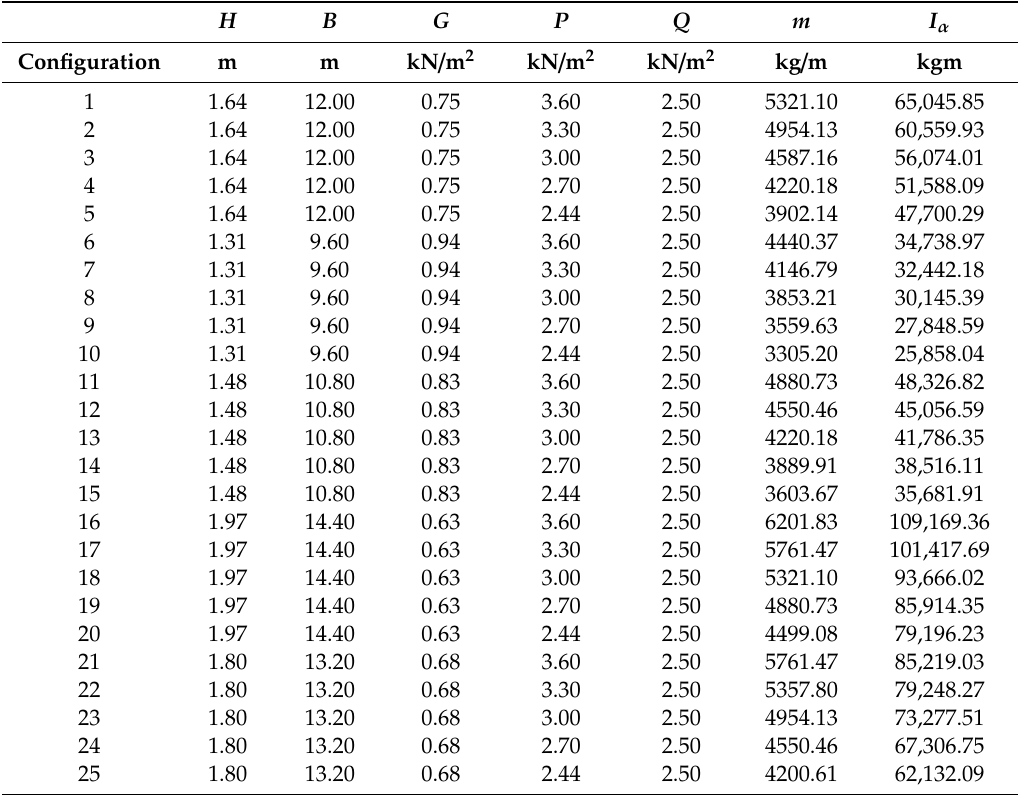
Table 3. Dimensions, structural loads, masses and inertia for the closed box section made of laminated